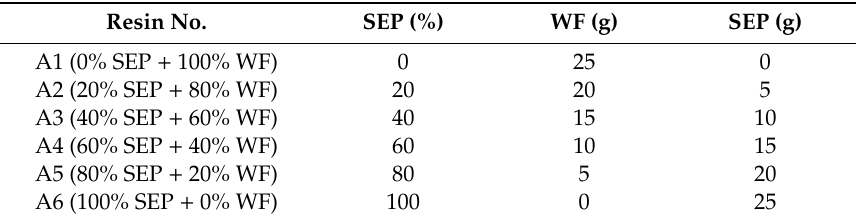
Table 1. The di ff erent formulations of sepiolite (SEP)-based fillers. Resin